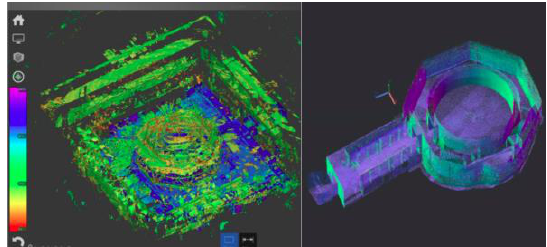
Fig. 4. A visualization of the whole laser point cloud dataset after registration (left); and a detail of the ice house only, after cleaning the point cloud in Autodesk Recap (right).